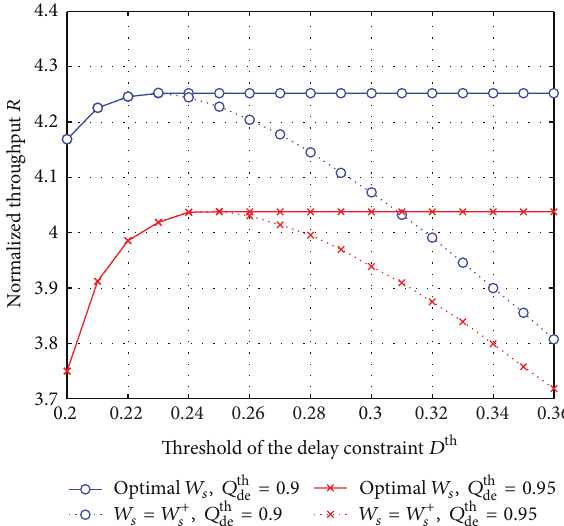
Figure 4: Normalized throughput R for various counting rules.